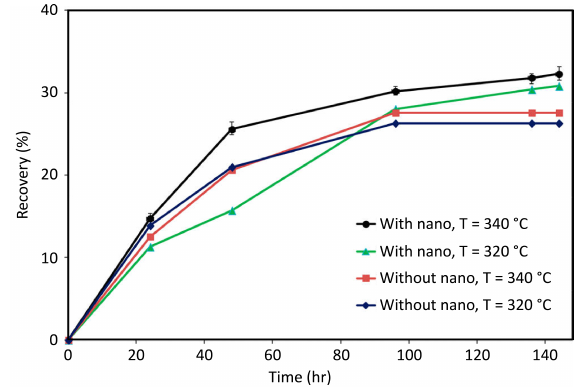
Figure 32. Recovery performance of hot vacuum gas oil (VGO) in the presence of trimetallic ultra-dispersed nanocatalysts at 320 and 340 °C. Figure reproduced from Ref.